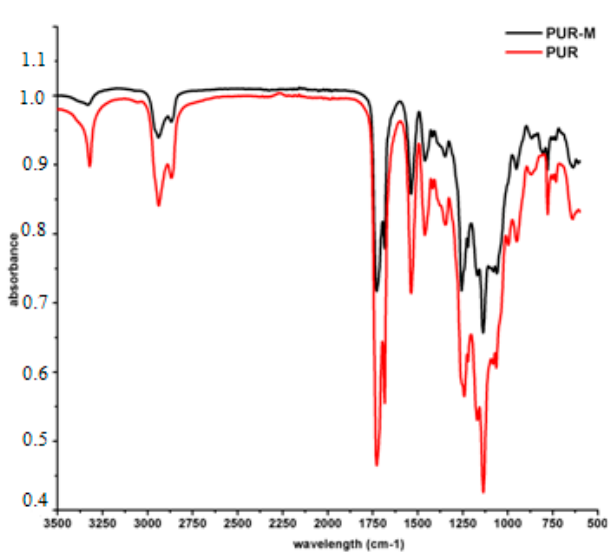
Figure 2. FTIR spectra of PUR (black) and PUR-M (red).